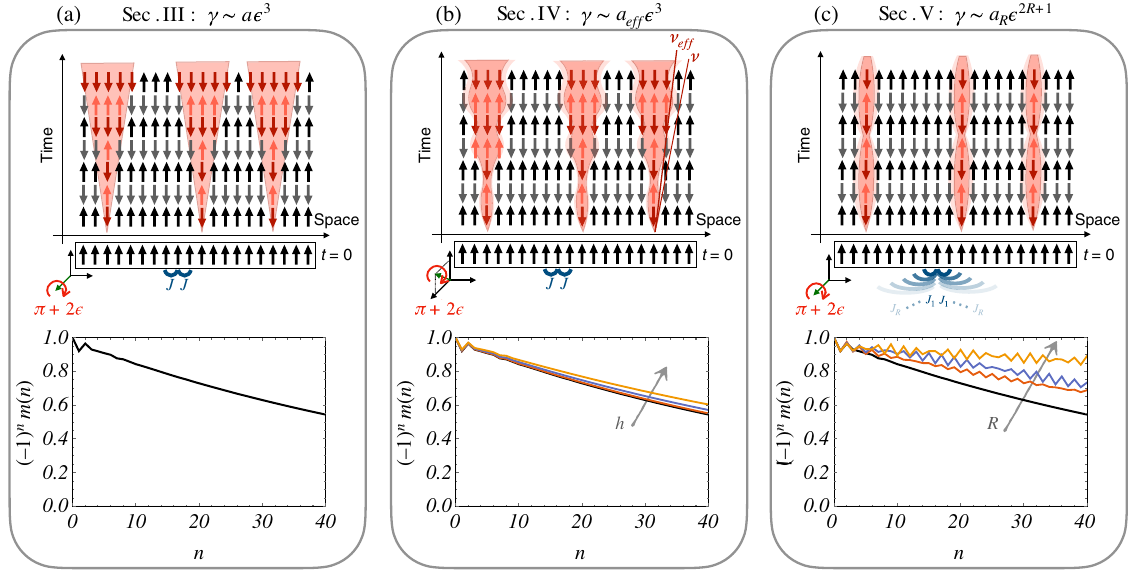
n Þi ∼ ð − 1 Þ n e − γ n at FIG. 1. Illustrative summary of the results of this paper for the decay of the stroboscopic order parameter m ð n Þ ¼ h Z j ð n in kicked Ising-type spin chains. (a) Top panel: standard transverse-field kicked Ising chain. The decay is driven by the integer times t n ¼ fractionalization of isolated spin flips, generated by small imperfections of magnitude ϵ in the kick, into pairs of unbound traveling domain walls. The exact decay rate in Eq. (7) is interpreted as γ ∼ ρ v , with ρ ∼ ϵ 2 the density of spin flips and v ∼ ϵ the spreading velocity of domain walls. Bottom panel: representative example [ J ¼ 0 . 685 , ϵ ¼ 0 . 2 in Eq. (6)]. (b) Top panel: tilt of the kick axis (green arrow in bottom-left sketches). The resulting domain-wall confinement hinders the spreading of reversed domains. However, the periodic flips average out the confining potential, resulting in deconfinement. Bottom panel: mild slowdown of the decay for increasing values of the longitudinal kick component [ h ¼ 0 . 2 , 0.4, 0.6 in Eq. (25)]. (c) Top panel: couplings of range R > 1 beyond nearest neighbors. The resulting form of domain- wall confinement is completely insensitive to periodic flips. We rigorously establish that, generically, the decay is only triggered by the fractionalizationofrarelargereversedbubblesintopairsofunbounddomainwalls.Thisresultsinaqualitativesuppressionofthedecayrateas γ ∼ ϵ 2 R þ 1 . Bottom panel: strong enhancement of the order-parameter lifetime upon increasing the couplings ’ range to a distance R ¼ 2 , 3, 4